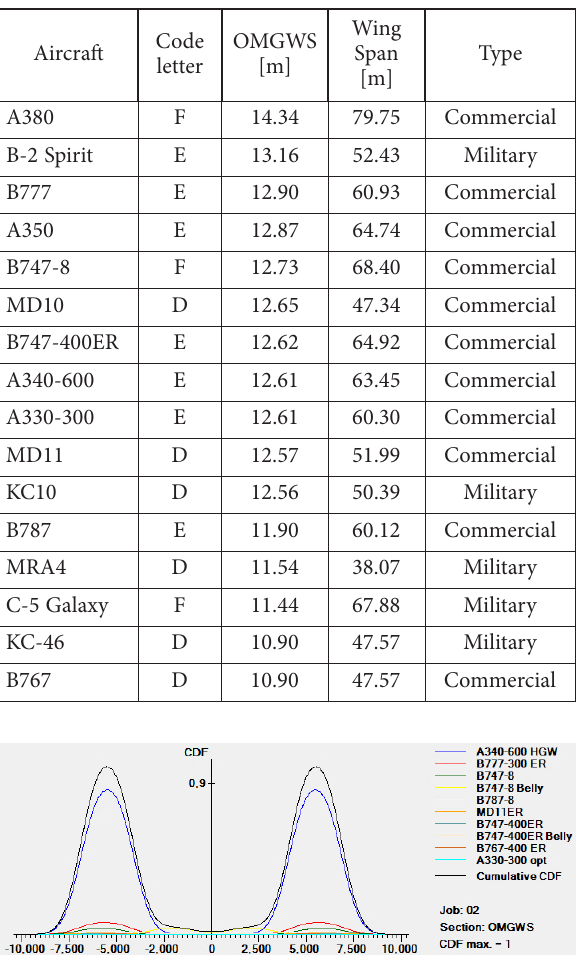
Table 2. Selected commercial and military aircrafts with the widest OMGWS